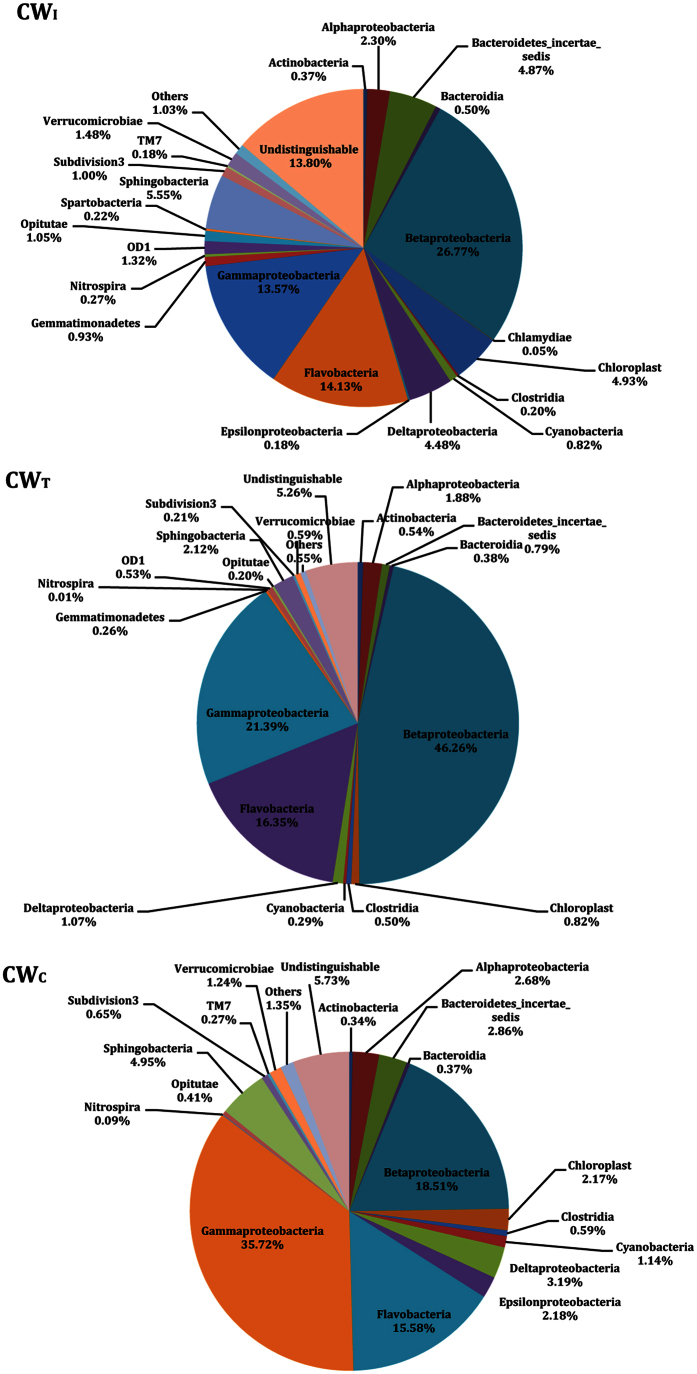
The relative abundances of the bacterial communities in CWI, CWT and CWC at the class level.Some classes (relative abundances < 0.15%, except for Nitrospira) are grouped into “Others”.